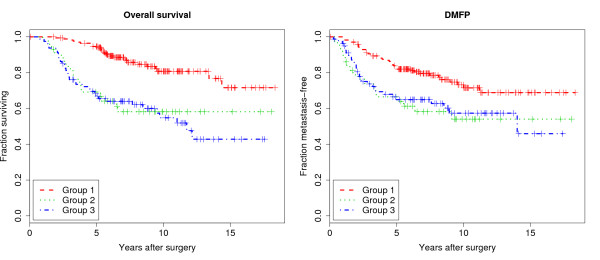
Kaplan-Meier curves for overall survival and DMFP for the three groups defined by BCMP11/ABCC11. The Kaplan-Meier survival curves (left) and DMFP curves (right) for each of the three groups defined by BCMP11 and ABCC11.